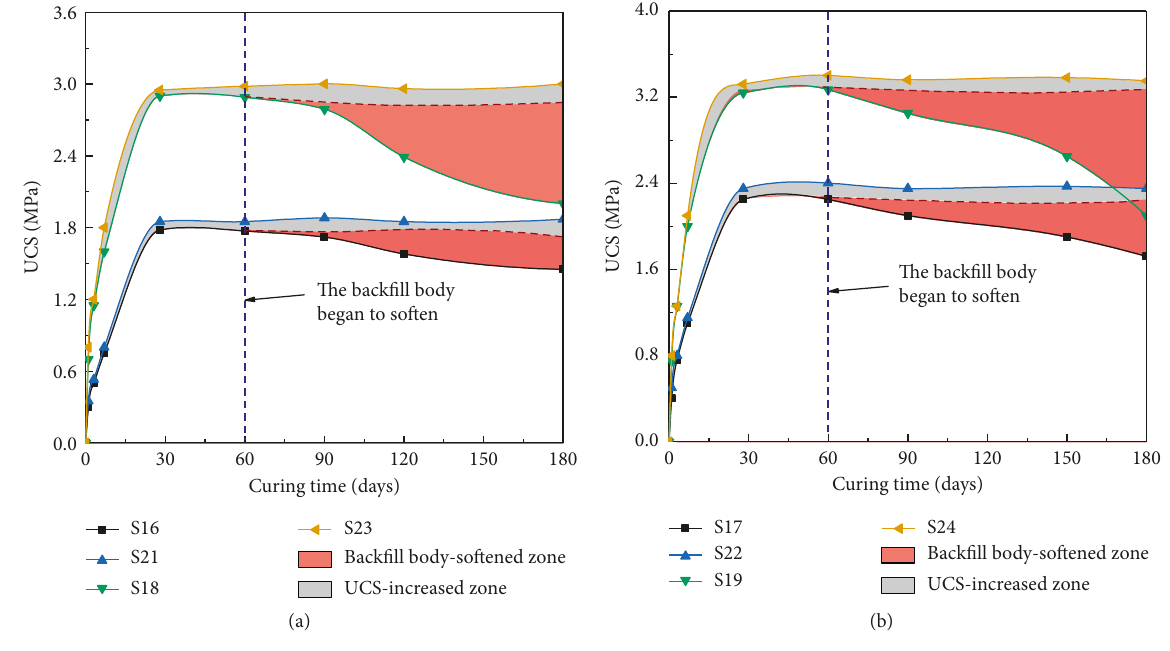
Figure 8: Long-term strength characteristics of the backfill bodies. Table 3: Leaching elements in the HPG, PS, and backfill bodies by